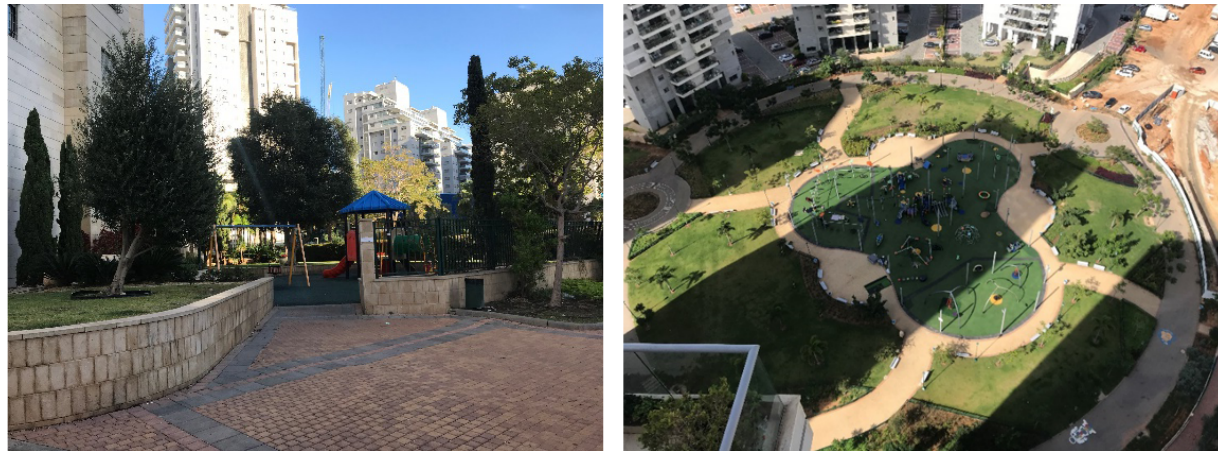
Figure 9. Green spaces of HRHCs. From left to right: small-scale Type C; large-scale Type C. Photographs by author Orly